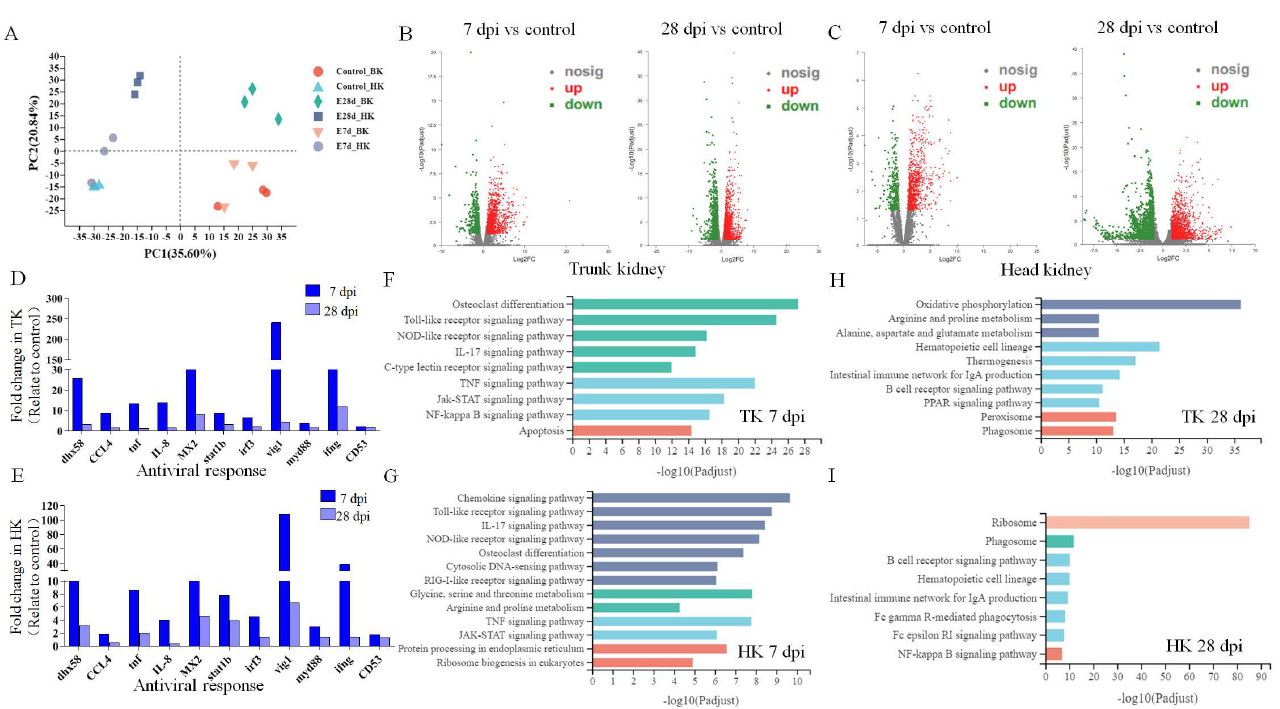
Figure 4. Transcriptome analysis was performed to analyze the immune response dynamics of trunk and head kidney of rainbow trout after IHNV infection. ( n = 3 fish per group.) ( A ) PCA (principal component analysis) cluster plots of gene expression levels in different samples. The horizontal axis represents the contribution degree of principal component 1 (PC1) in the two-dimensional graph to the differentiated samples, and the vertical axis represents the contribution degree of principal component 2 (PC2) in the two-dimensional graph to the differentiated samples. The blue, gray, and deep blue represent the head kidney, and the red, green, and orange represent the trunk kidney. Different shapes indicate different groups. ( B , C ) Volcano plot displaying the DEGs distribution in the trunk kidney ( B ) and head kidney ( C ) of rainbow trout at 7 dpi (left) and 28 dpi (right) in the infected group compared with control group. Red spots: expression fold change of >2 and FDR of <0.05; green spots: expression fold change of <2 and FDR of <0.05; gray spots: no difference in expression. The horizontal axis represents log2(FC), and the vertical axis represents − log10(FDR). ( D , E ) Representative immune-related genes (anti-virus, antigen presentation, and inflammatory) in the trunk kidney ( D ) and head kidney ( E ) modulated by IHNV infection at 7 and 28 dpi. Data are expressed as mean fold increase in expression of these genes based on RNA-seq results. ( F – I ) KEGG pathways that were significantly altered in trunk kidney (F and H) and head kidney ( G , I ) of rainbow trout at 7 and 28 dpi versus control fish revealed by RNA-Seq. Fold change differences between control and IHNV-infected groups were calculated using cutoff of 2-fold.